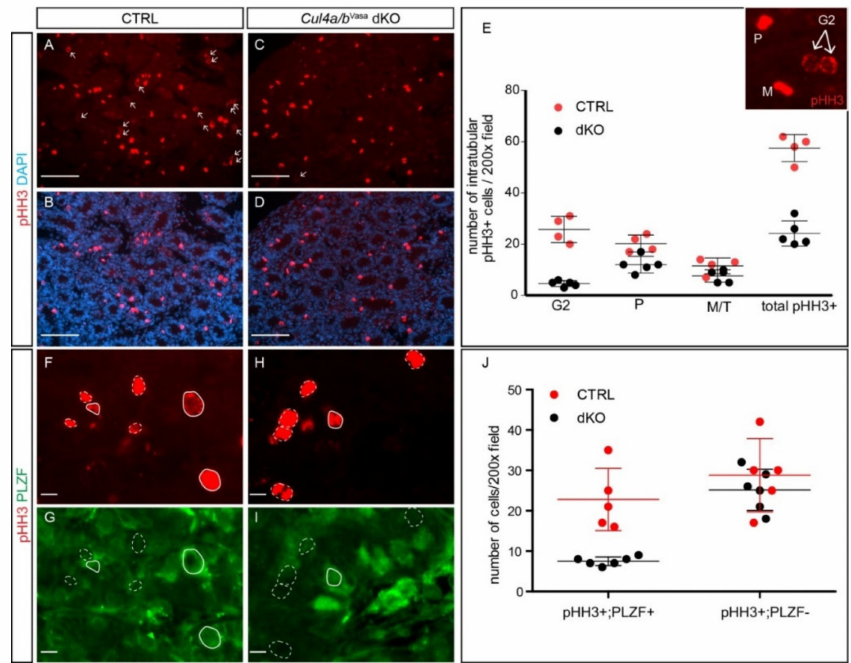
Figure 3. Cul4 genes are critical to maintain male germ cell proliferation. ( A – D ) IF staining of phospho-histone H3 (pHH3, red) in P5 CTRL and Cul4a/b Vasa dKO testes. Arrows point to pHH3- positive G2 phase cells. ( E ) Quantification of pHH3-positive cells in seminiferous tubules revealed significant reduction in number of pHH3+ cells in the dKO, particularly in cells at G2 phase. Inset shows typical pHH3 staining pattern of cells at prophase (P), metaphase (M) and G2 phase. M/T, metaphase/telophase. Total: CTRL 57.5 ± 5.3, dKO 24.0 ± 5.3, p = 2.5 × 10 − 5 ; G2: CTRL 25.8 ± 5.1, dKO 4.8 ± 1.3, p = 3.9 × 10 − 5 ; P: CTRL 20.2 ± 3.3, dKO 13.0 ± 2.7, p = 0.007; M/T: CTRL 11.5 ± 3.1, dKO 13.0 ± 2.7, p = 0.07; n = 4 for CTRL and n = 5 for dKO. ( F – I ) Double IF staining of pHH3 (red) and PLZF (green) of P5 CTRL and dKO testicular sections. Solid white lines circle out pHH3+; PLZF+ proliferating germ cells, dashed white lines circle out pHH3+; PLZF- cells. ( J ) Quantification of pHH3/PLZF double IF cells revealed significant decrease in number of double positive cells. pHH3+; PLZF+: CTRL 22.8 ± 7.7, dKO 7.5 ± 1.0, p = 8.8 × 10 − 4 ; pHH3+; PLZF − : CTRL 28.8 ± 9.1, dKO 25.1 ± 5.1, p = 0.42; n = 5 for CTRL and n = 6 for dKO. Scale bars: 50 µ m in ( A – D ), 20 µ m ( F – I